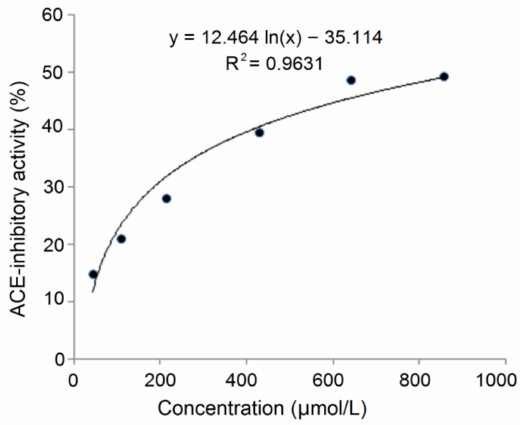
Figure 8. The regression analysis on ACE-inhibitory activity of SAPPP after the simulated gastroin- testinal